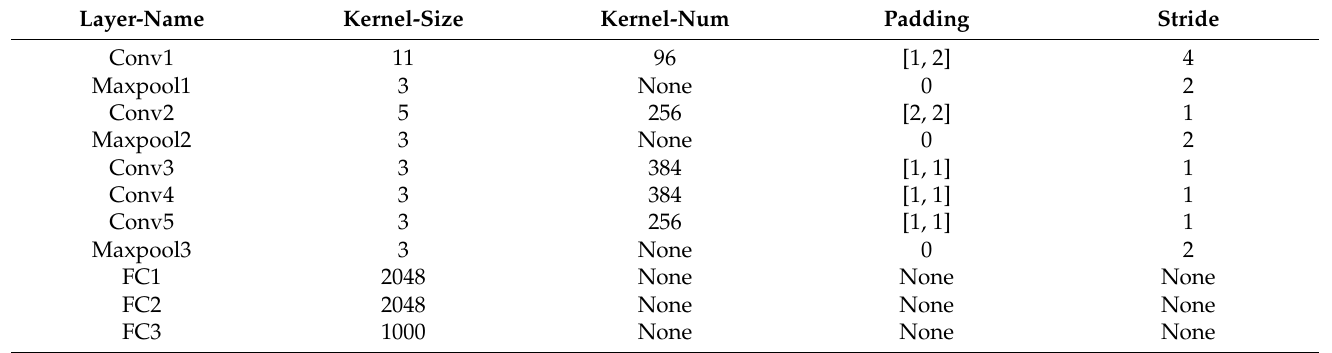
Table 2. All layer parameters for